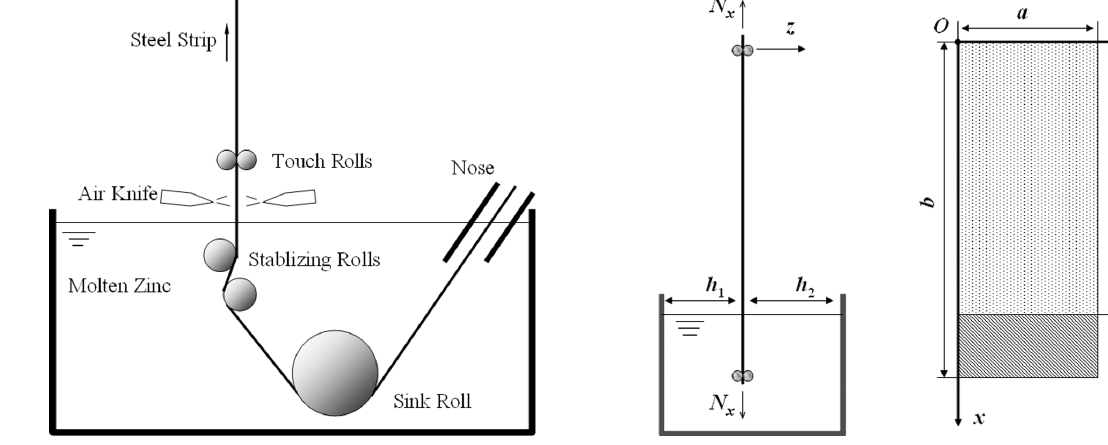
Fig. 1. Schematic diagram of a continuous hot-dip galvanizing line. Fig. 2. The tensioned rectangular plate partially immersed in fluid with two simple